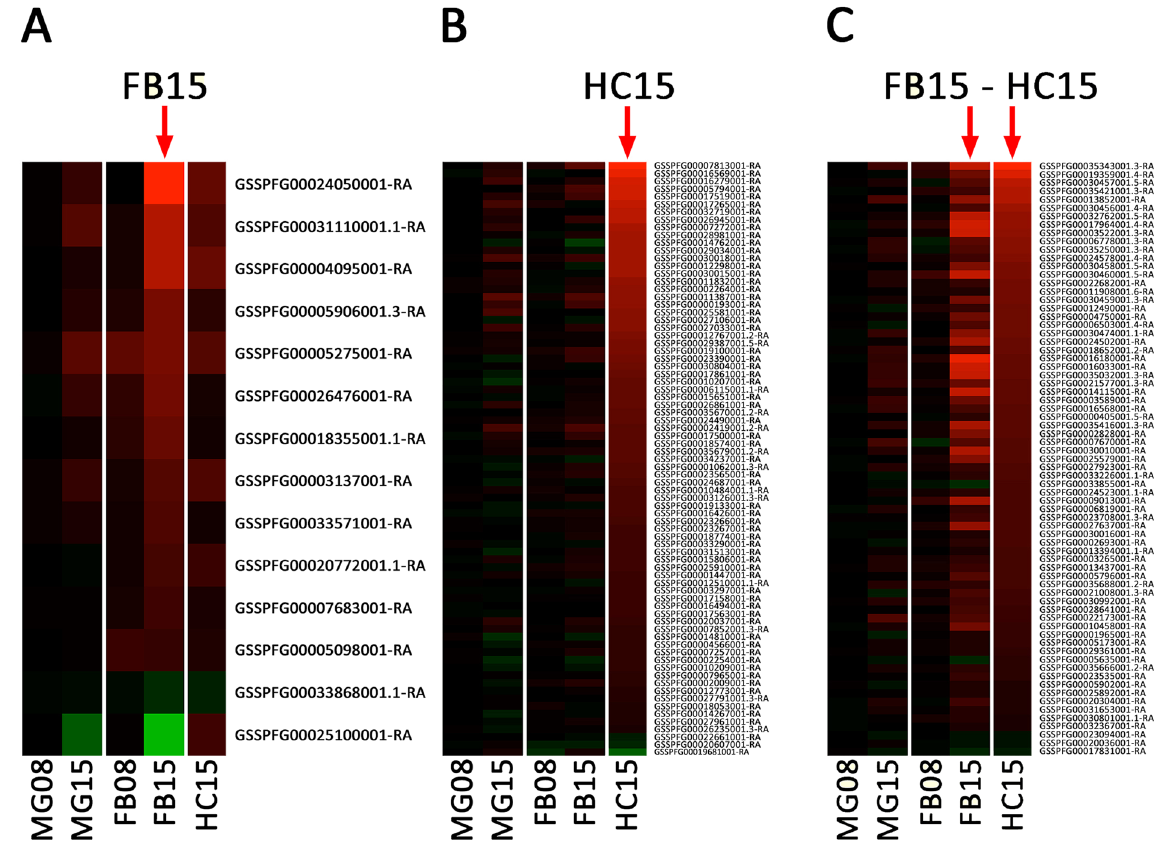
Figure 3. Fat body and hemocytes associated responses. As in Fig. 2, heatmaps of differential expression for genes ( A ) specific to FB15 (14 genes), ( B ) specific to HC15 (77 genes) and ( C ) common to FB15 and HC15 (71